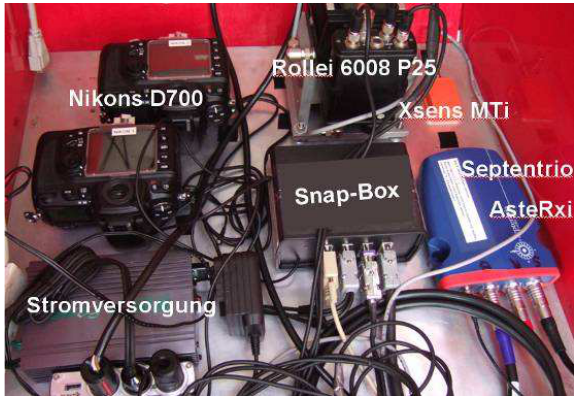
Figure 5: Setup of a metric RGB Camera and 2 modified Nikon for capturing images in the NIR red edge